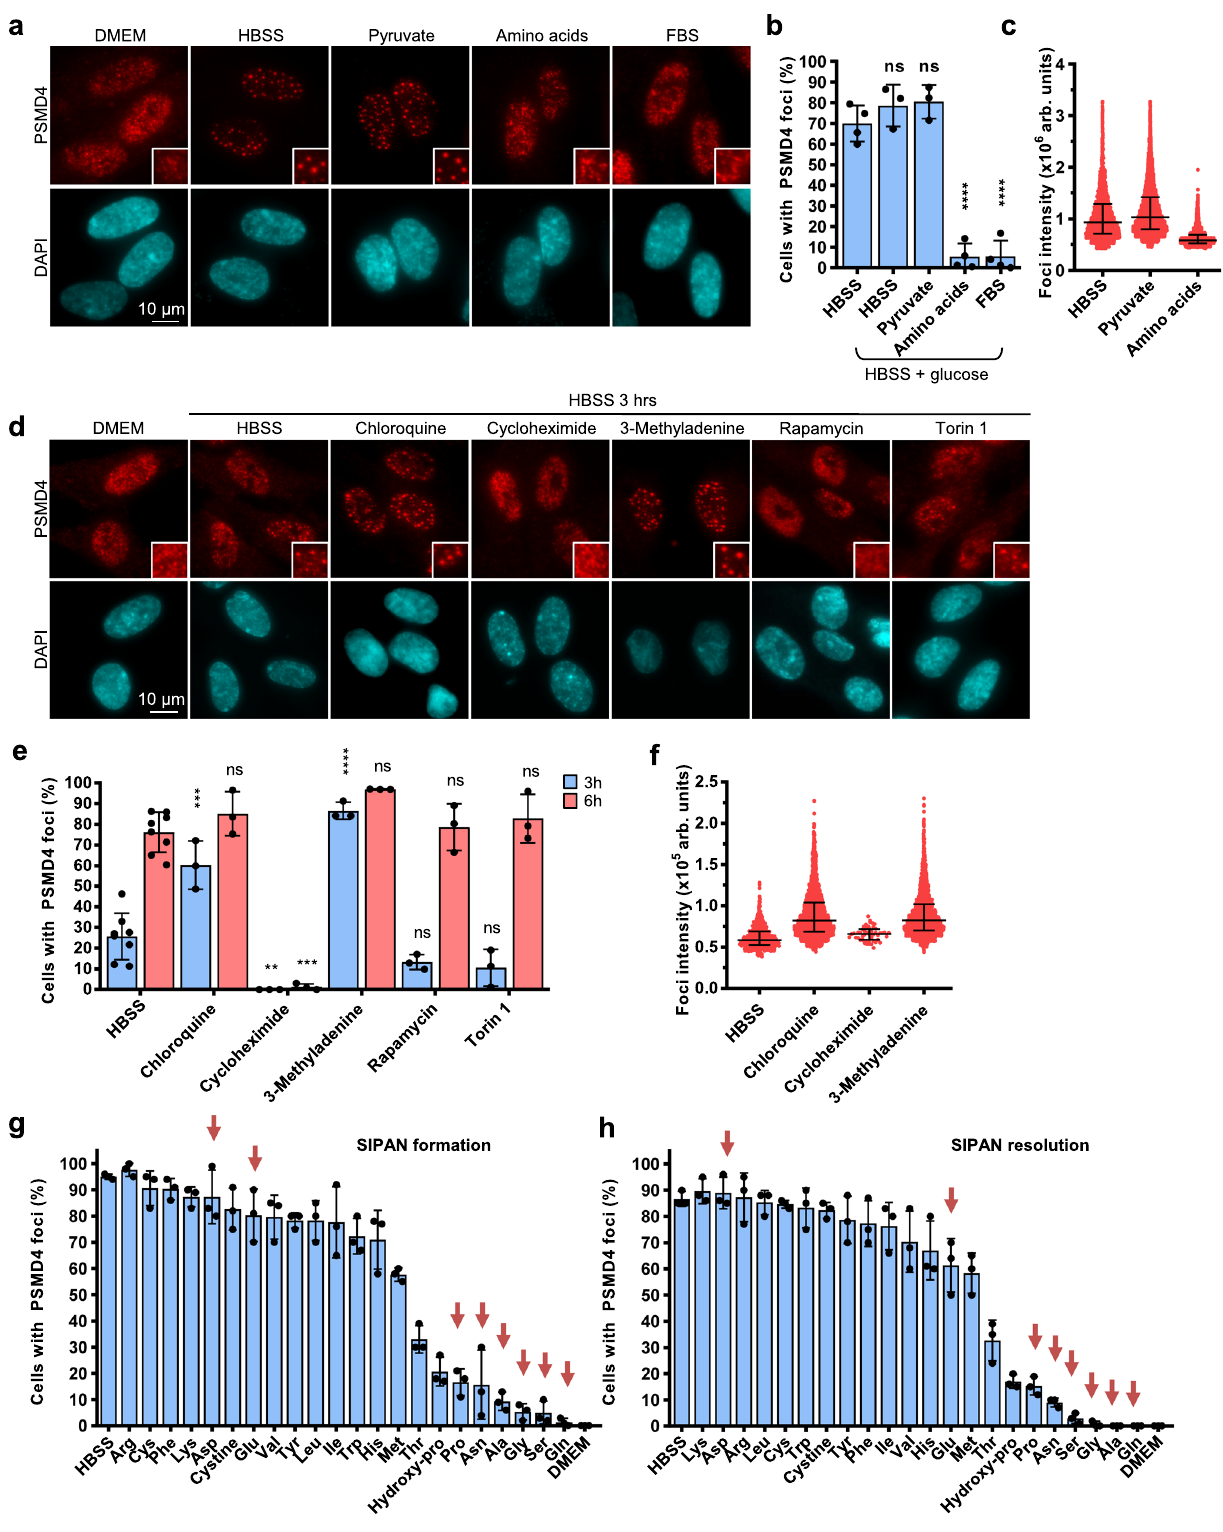
images (10 frames) were taken prior to FRAP activation for normalization of the data. Photobleaching of EGFP was generated by scanning the selected ROIs for 10